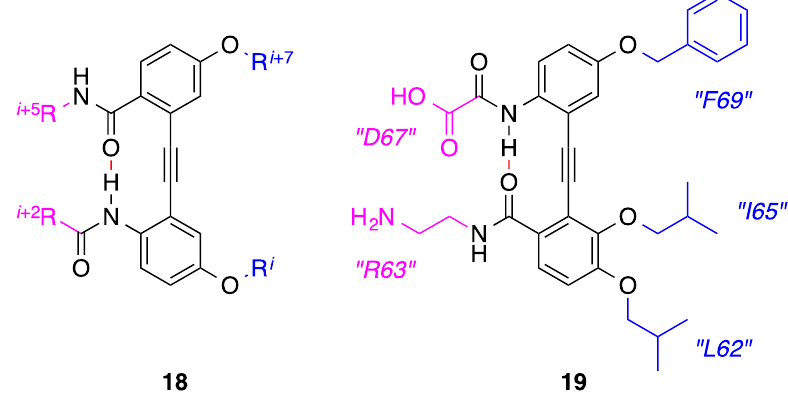
Figure 7. An intramolecular hydrogen bond (dashed line) influences the projection of side-chains from opposing faces of a diphenylacetylene